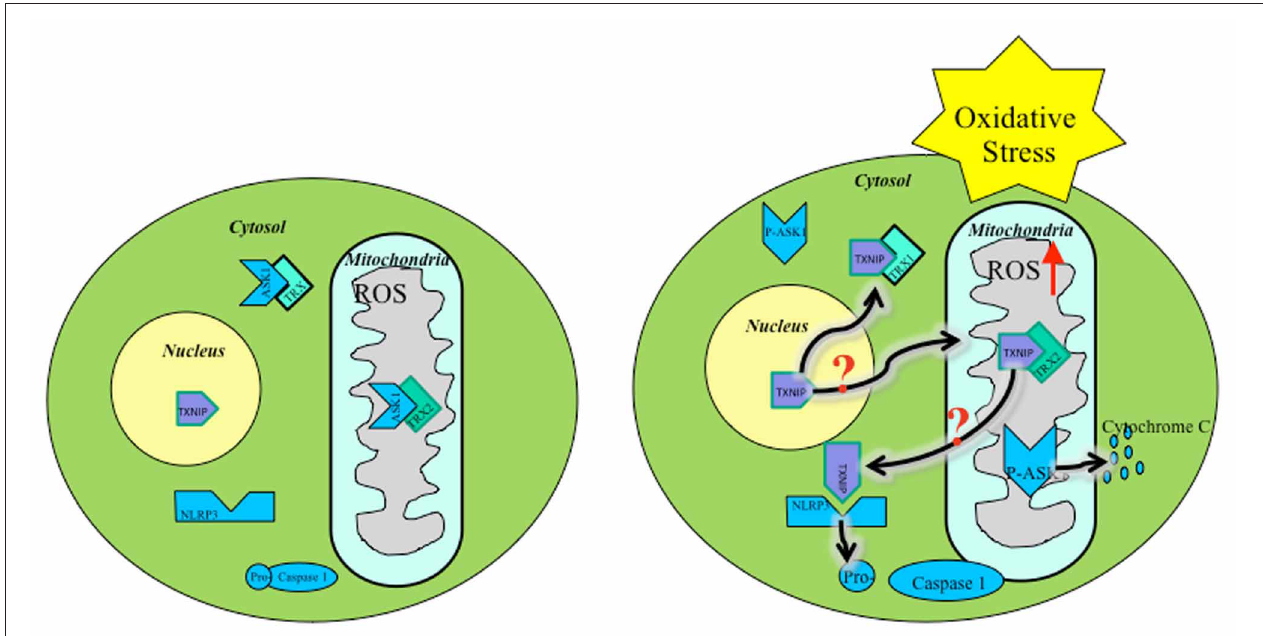
FIGURE 1 | Oxidative stress mediated TXNIP shuttling: TXNIP localization under basal conditions (Left), TXNIP rests in the nucleus. TRX1-ASK1 binding in the cytosol and TRX2-ASK1 binding in the mitochondria maintains low ROS. Under oxidative stress ( Right ), TXNIP shuttles to the